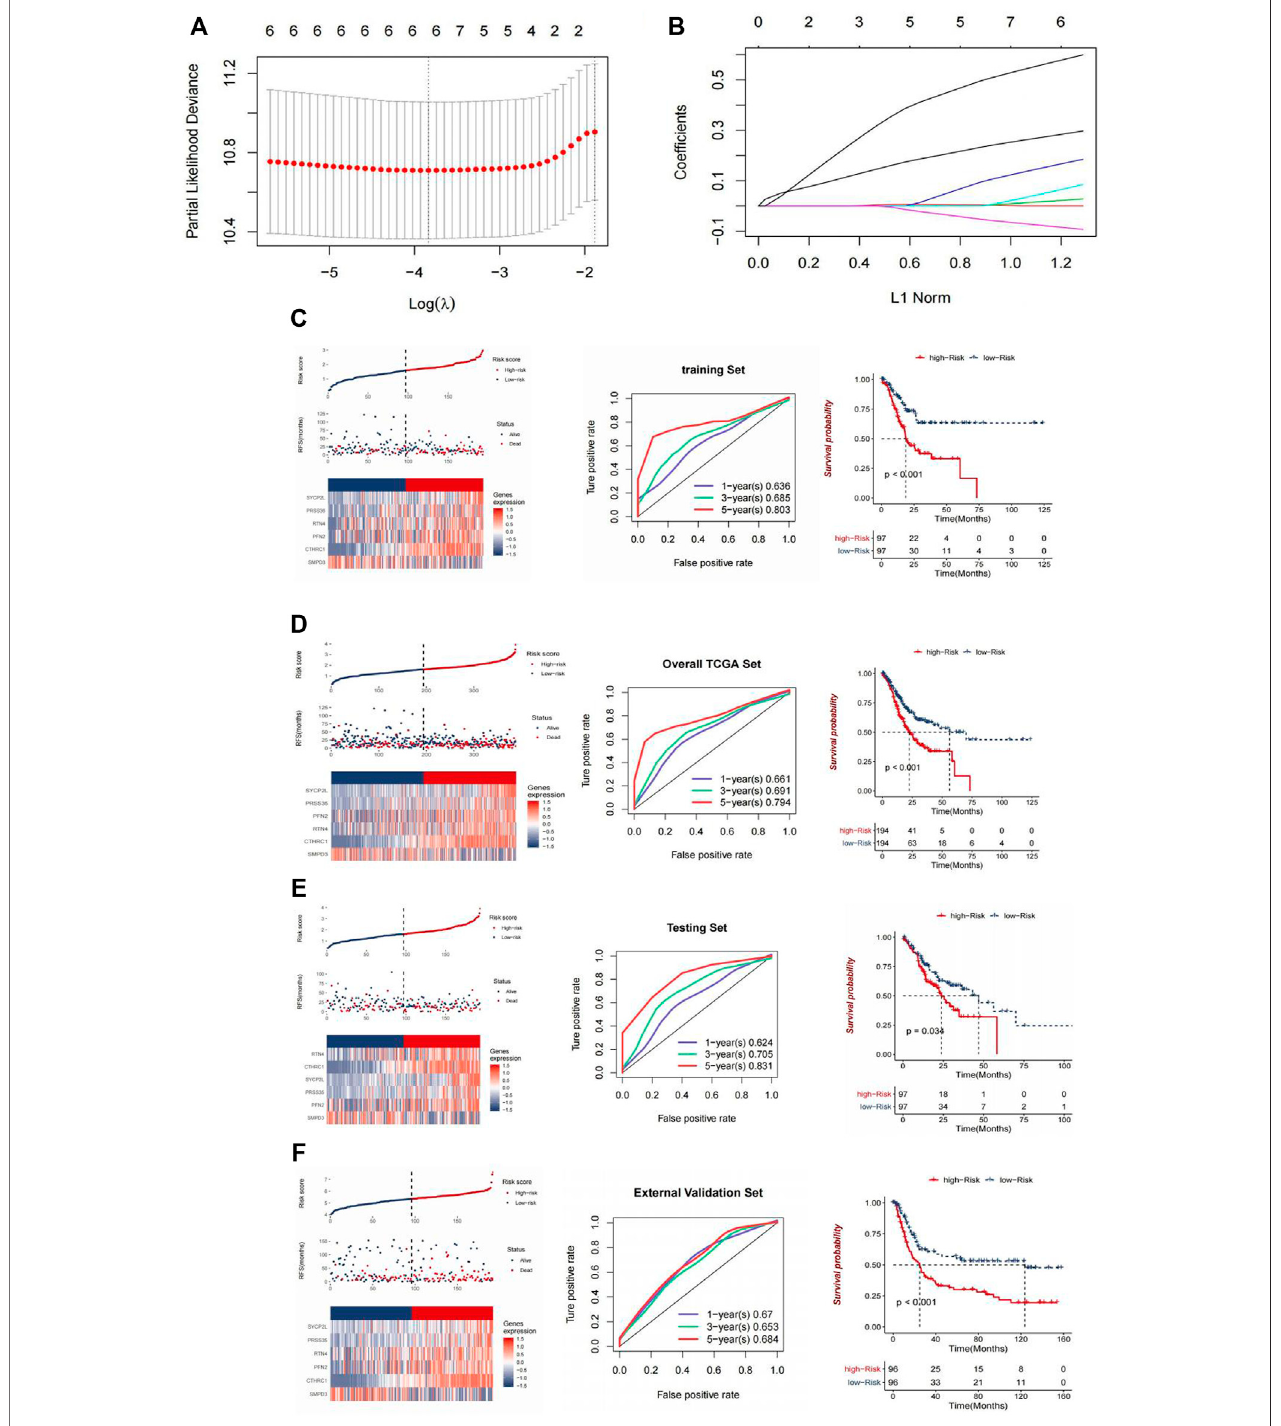
FIGURE 6 | Construction and validation of CDK6-AS1. (A) Tuning parameter lambda ( λ ) selected by cross-validation error curve. (B) LASSO coef fi cient pro fi les of six genes. (C,D) Relationship between the survival status/risk score rank, mRNA expression heat map of 6 genes and survival time (days)/risk score rank. Left: survival status/risk score rank, mRNA expression heat map of 6 genes. Middle: Time-dependent ROC curves for OS of the TCGA-LAML training data set. The AUC was assessedat1,3,and5 years.Right:Kaplan-MeierOSanalysisofgastriccancerpatientsinlow-riskandhigh-riskgroups. p valuewascalculatedusingthelog-rank test. p < 0.001. (E,F) Validation using an internal set (E) and an external set (F) .